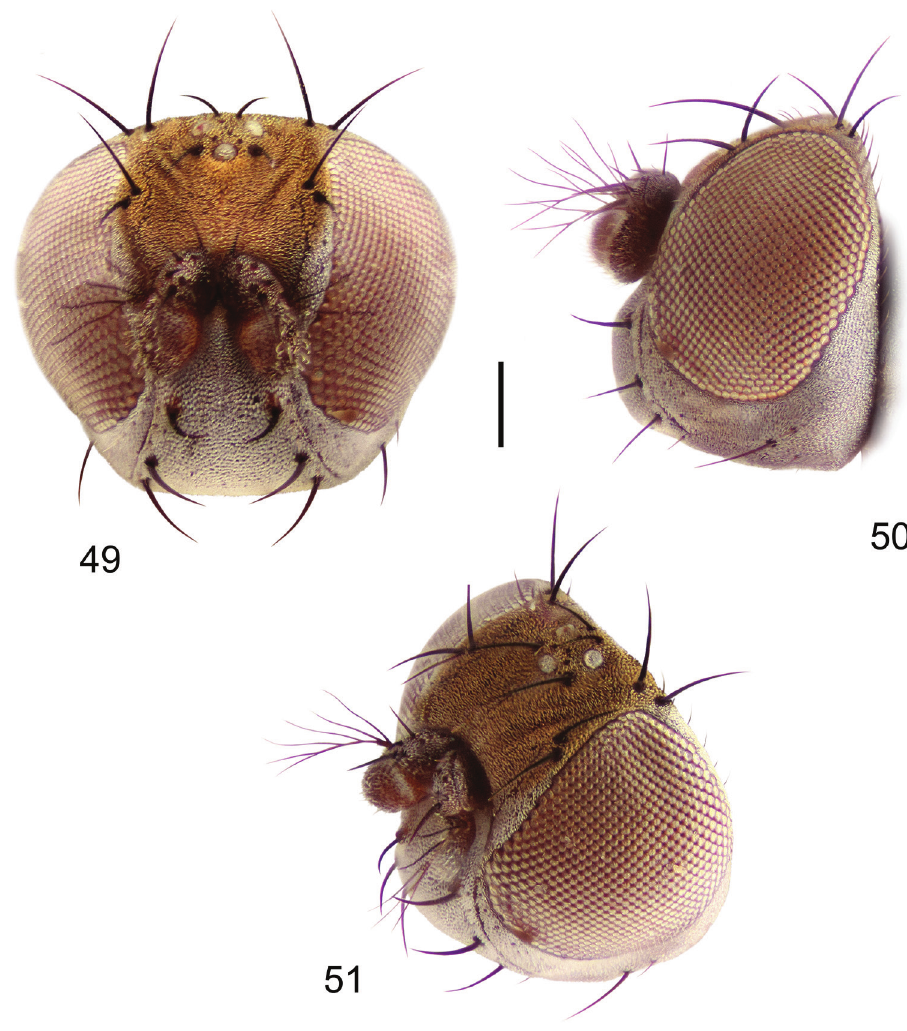
pered to narrowly rounded anterior apex, in ventral view (Fig. 54) generally as a gen- tly curved arrowhead with posterior half generally narrower, posterior margin widely and moderately deeply emarginate with narrow, lateral arms, tapered to anterior portion of base, anterior portion elongate, V-shaped with lateral margins shallowly curved, with elongate, narrow, lateral, posterior extended processes that are aligned parallel to overall orientation of hypandrium, anterior margin tapered to bluntly rounded